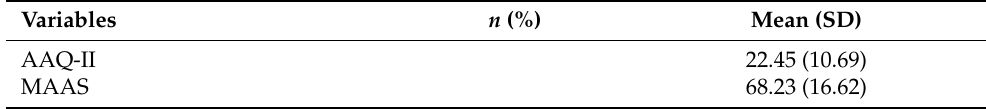
Table 4. Psychological Flexibility and Mindfulness of Caregivers of PwD.